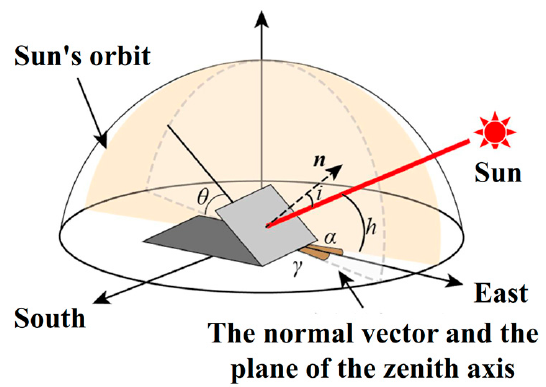
Figure 2. Schematic Diagram of Solar Incidence Angle.